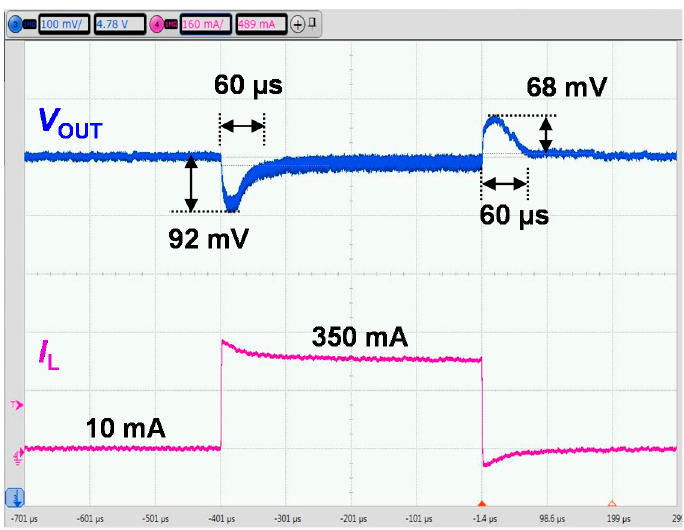
Figure 13. Load transient response.